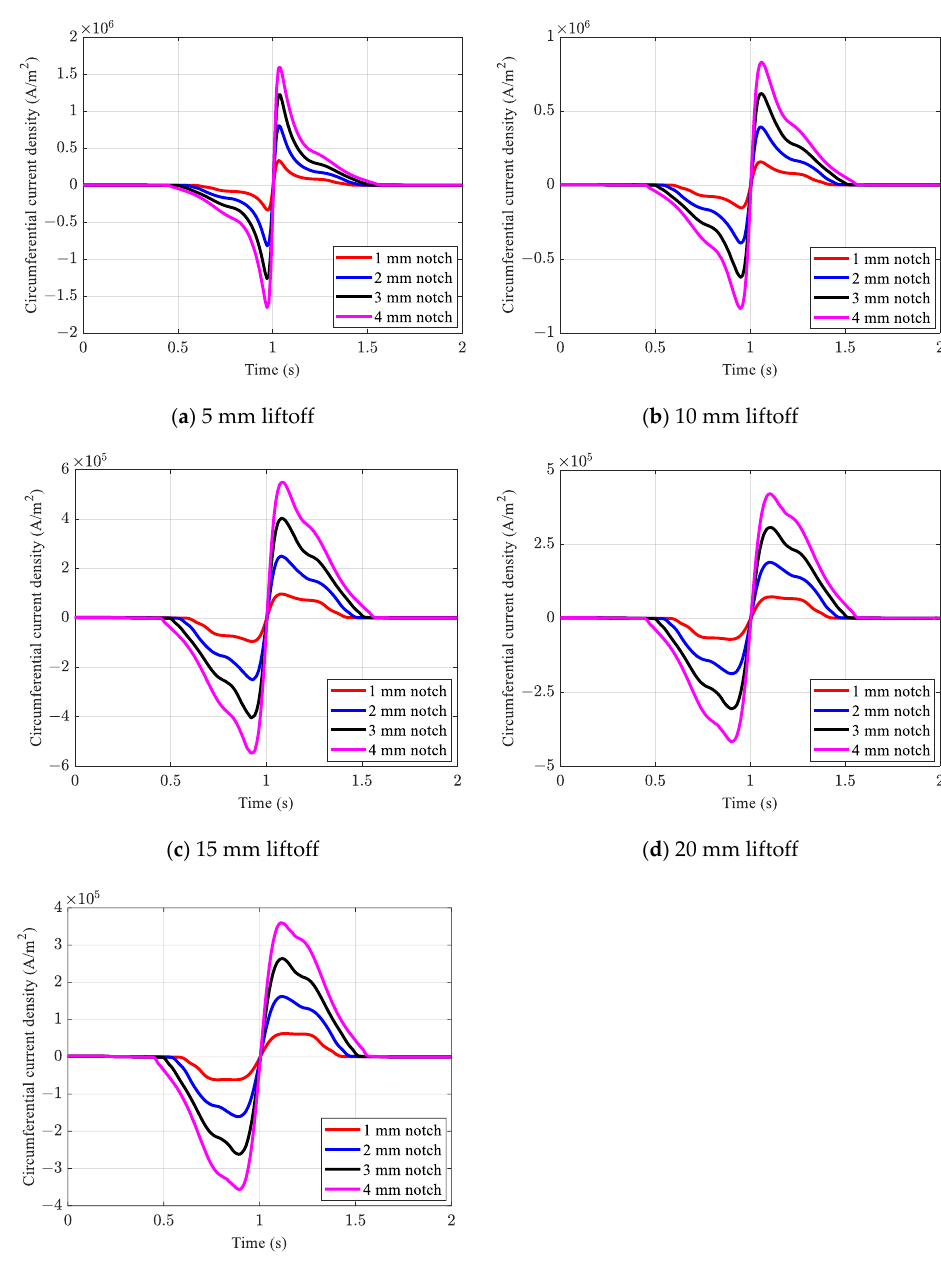
Figure 10. Effects of varying liftoff on circumferential current induction obtained from the proposed method.